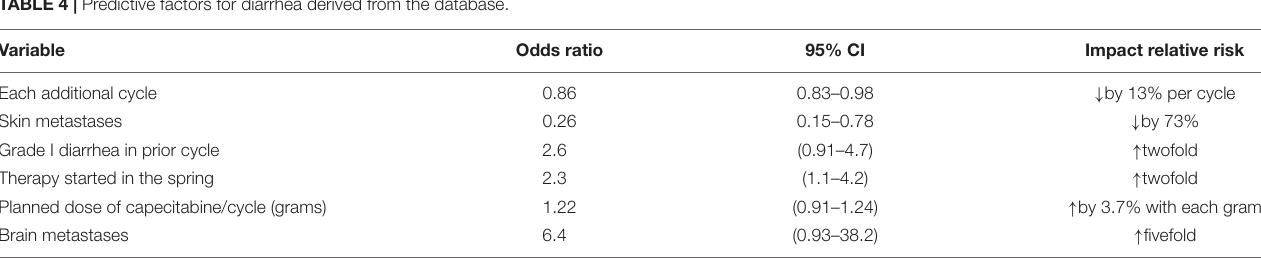
TABLE 4 | Predictive factors for diarrhea derived from the